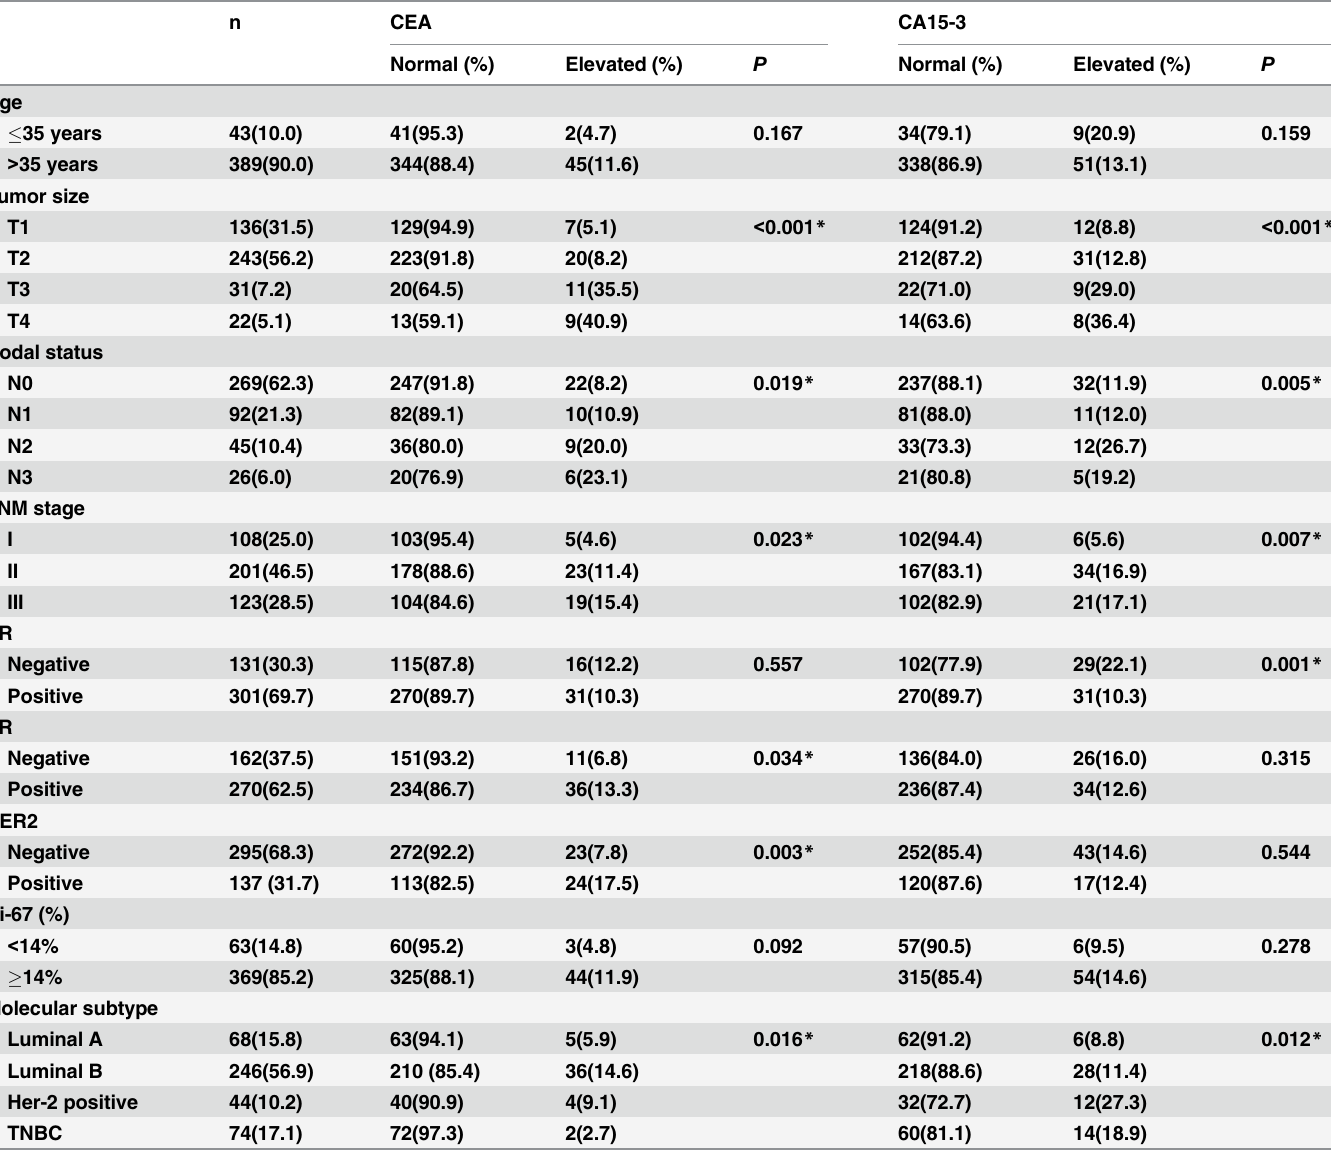
Table 1. Clinicopathological characteristic of subjects and correlation between serum CA 15 – 3 and CEA level and clinicopathological